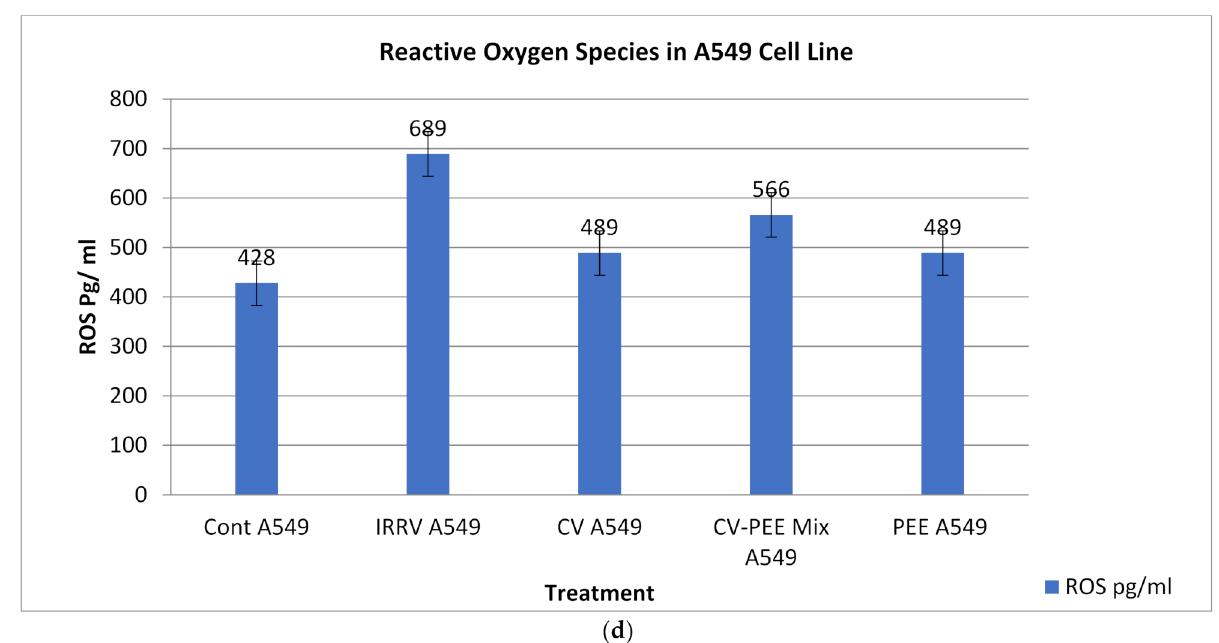
Figure 6. ( a ): Evaluation of glutathione reductase (GSH) and malondialdehyde (MDA) post [PC3] cell line treatment with IRRV, CV, CV-PEE Mix, and PEE. ( b ) Evaluation of glutathione reductase (GSH) and malondialdehyde (MDA) post [A549] cell line treatment with IRRV, CV, CV-PEE Mix, and PEE. ( c ) Evaluation of reactive oxygen species post [PC3] cell lines treated with IRRV, CV, CV-PEE Mix, and PEE. ( d ) Evaluation of reactive oxygen species post [A549] cell lines treated with IRRV, CV, CV-PEE Mix, and PEE.